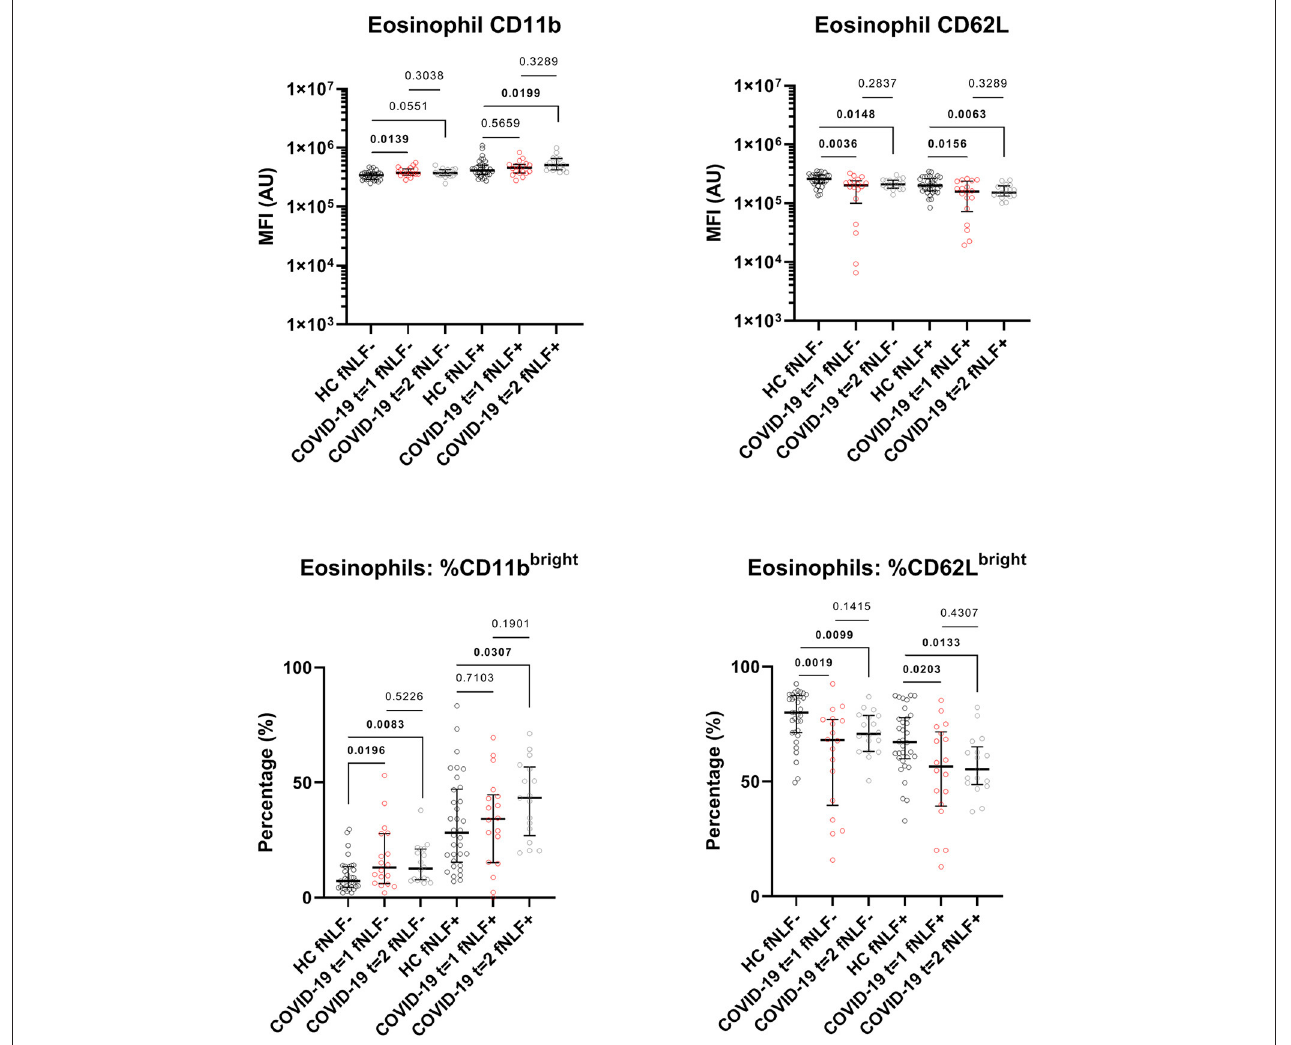
FIGURE 6 | Median fluorescence intensity (MFI) in arbitrary units (AU) for markers on eosinophils during ( t = 1) and 3 to 6 months after ( t = 2) active COVID-19 disease in primary care patients. Healthy controls (HC) are displayed as reference. fNLF-samples are measured in the absence of fNLF, whereas fNLF + samples are measured in the presence of the formylpeptide (10 µ M). Statistical significance was tested using the Mann-Whitney U Test for continuous variables and the Wilcoxon matched-pairs signed rank test for paired analyses.